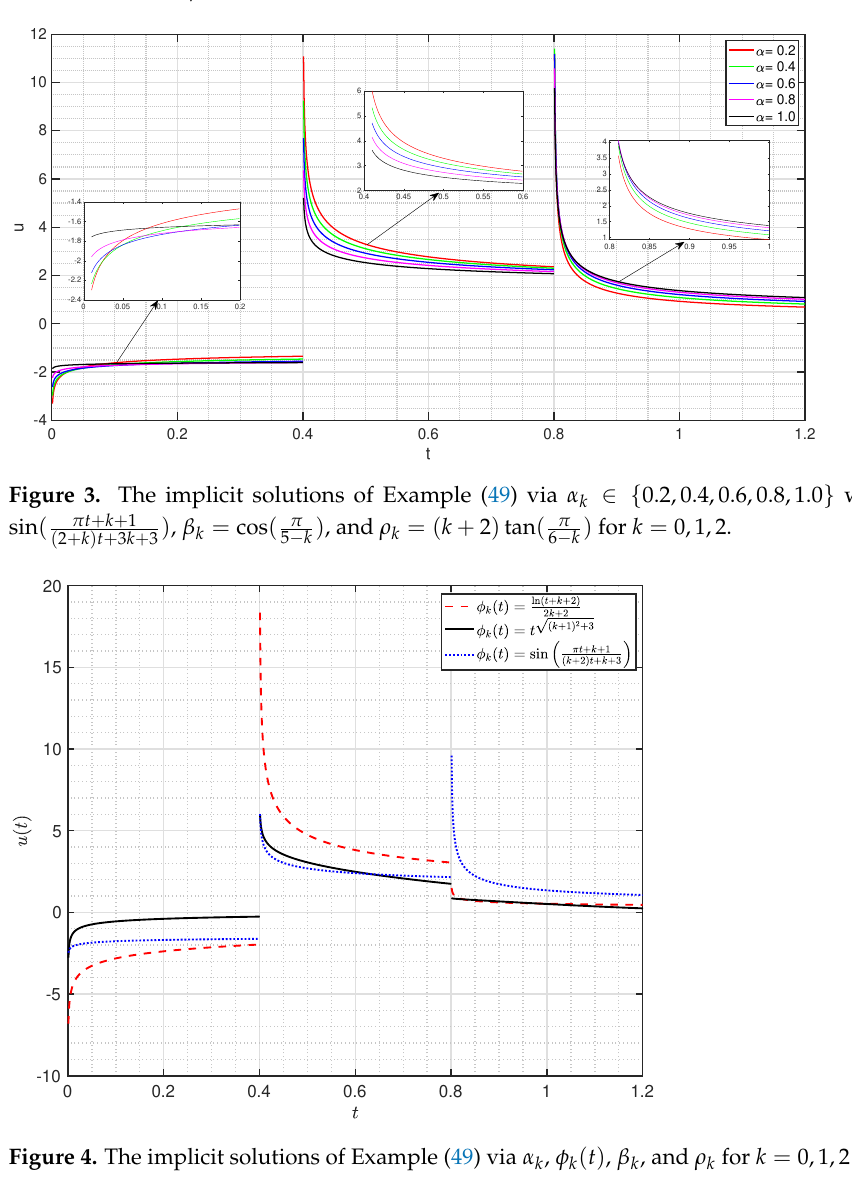
Figure 4. The implicit solutions of Example (49) via α k , φ k ( t ) , β k , and ρ k for k = 0,1,2 as in Table